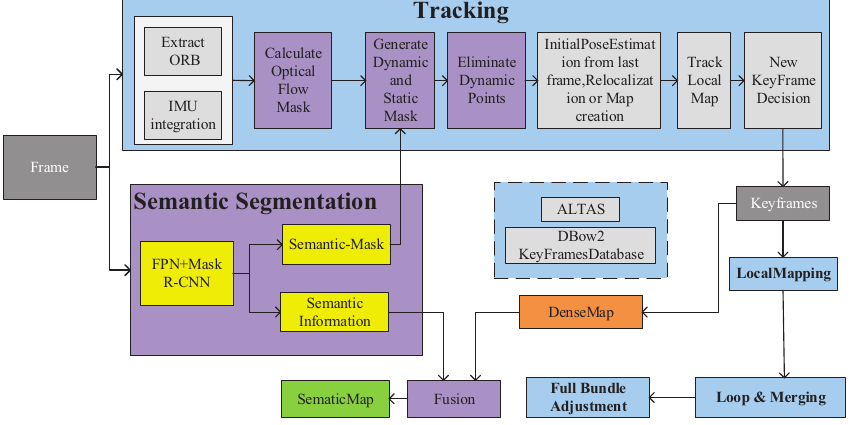
Figure 1. The main framework of the